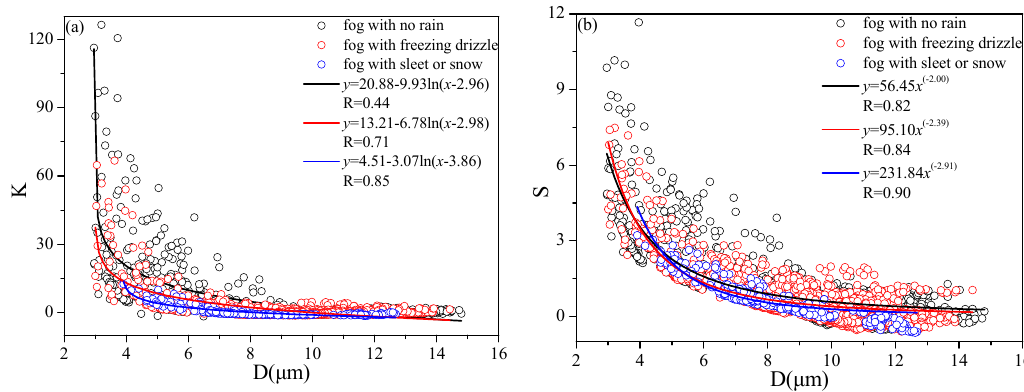
Figure 5. The scatterplot of K and S calculated from the 1-min average data and the corresponding fitting curves during the no-precipitation (one hour before and after precipitation), freezing drizzle, and sleet/snow periods. ( a ) Kurtosis ( K ) as a function of diameter ( D ); ( b ) skewness ( S ) as a function of D .